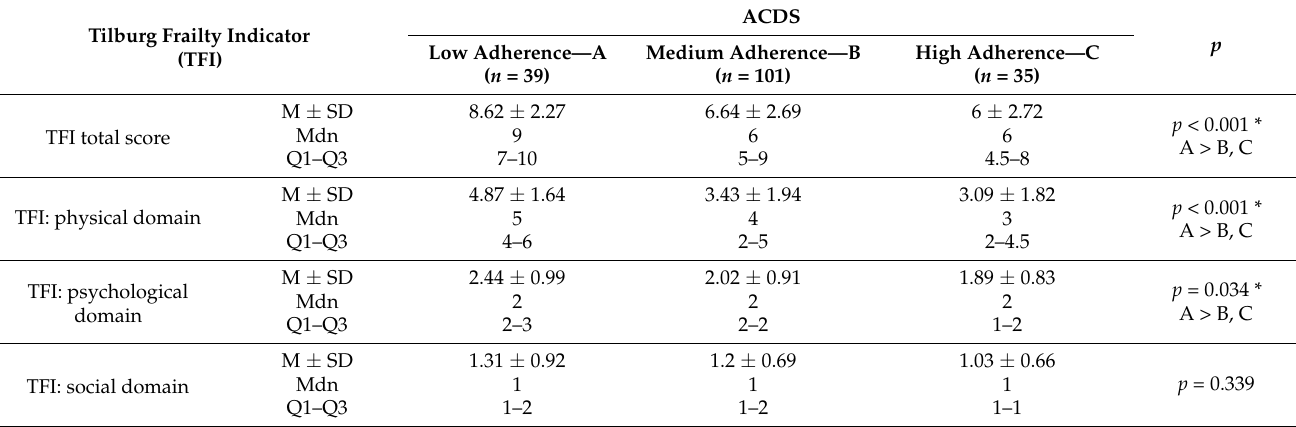
Table 5. The correlation between adherence to medication and frailty syndrome.